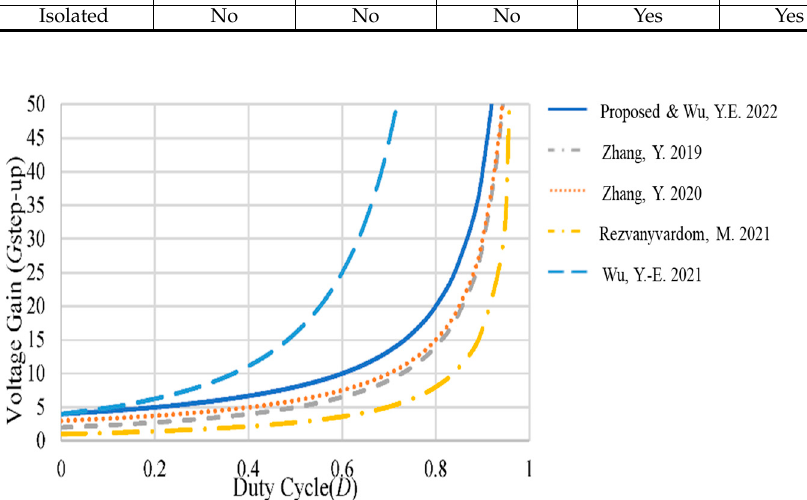
Figure 15. Voltage gain of the compared converters in the step-up mode [20,21,24,27,30].